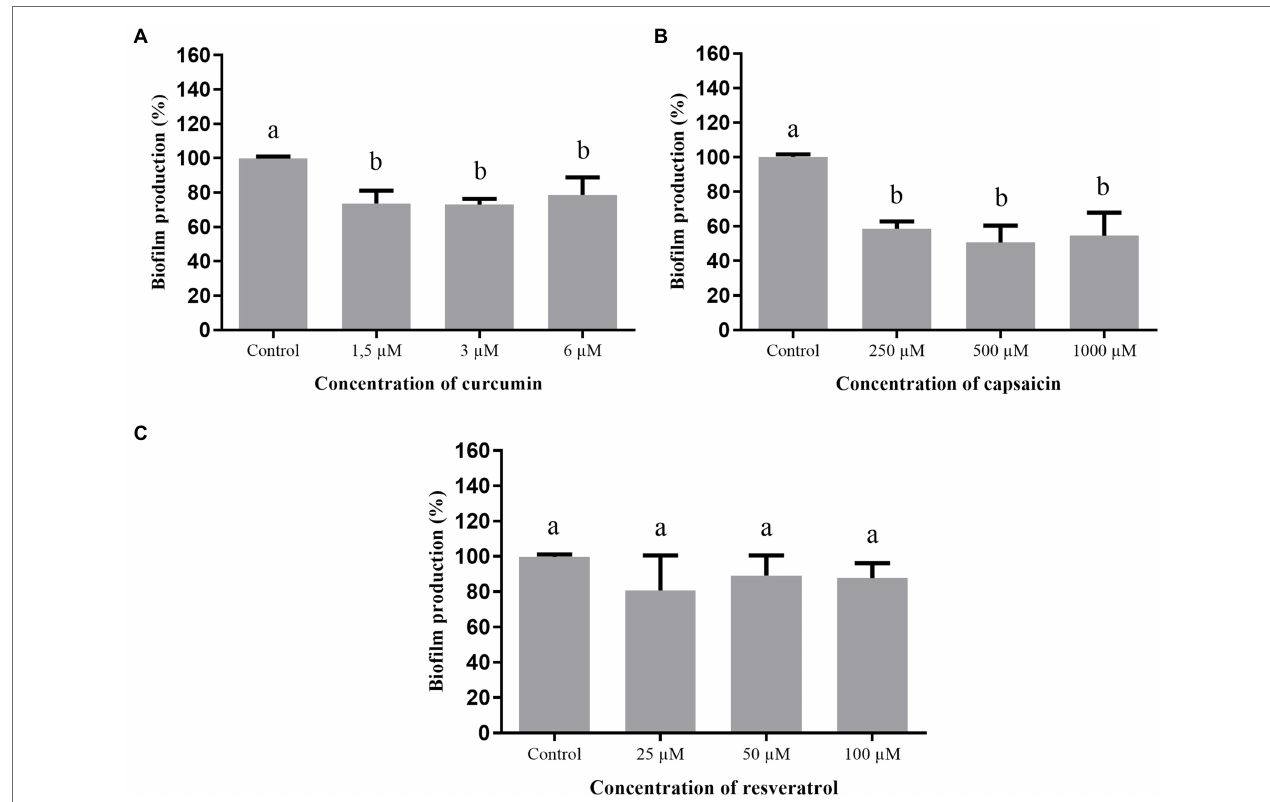
FIGURE 5 | Effect of phenolic compounds on biofilm formation by Salmonella Montevideo 163 expressed as percentage of production, when compared to the control (100%). curcumin (A) ; capsaicin (B) ; resveratrol (C) ; and control = biofilm formation in LB broth + DMSO (1%). Means followed by different letters differ among themselves by Tukey’s test ( p <